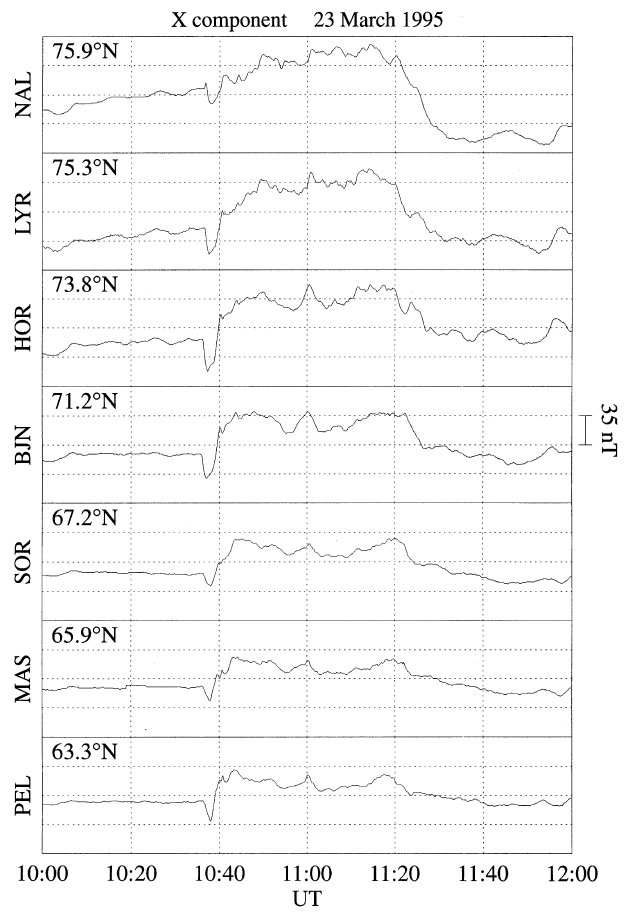
Fig. 4. The dayside X component (geographic north) magnetic response measured during the interval 1000–1200 UT on 23 March 1995 by seven magnetometers of the IMAGE